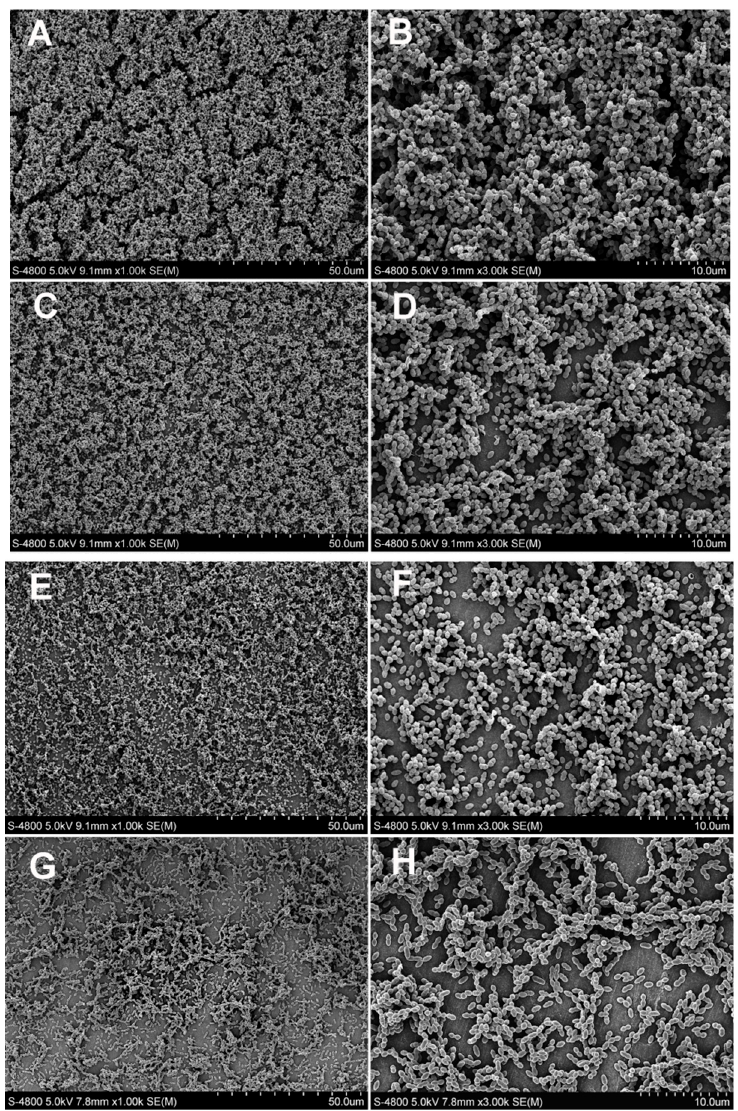
Figure 2. The scanning electron micrographs (magnification 1000× and 3000×) of Streptococcus mutans biofilms on the specimens in the control group and in the EGCG groups: SB 2 ( A , B ); EGCG 200 ( C , D ); EGCG 400 ( E , F ); and EGCG 600 (G, H ). Dense biofilms have formed on the surface of the SB 2 specimens. EGCG 200, 400, and 600, epigallocatechin-3-gallate at 200 µg/mL, 400 µg/mL, and 600 µg/mL, respectively; EGCG-3Me 200, 400, and 600, epigallocatechin-3- O -(3- O -methyl)-gallate at 200 µg/mL, 400 µg/mL, and 600 µg/mL, respectively; SB 2, Single Bond 2 (3M ESPE, St. Paul. MN, USA).